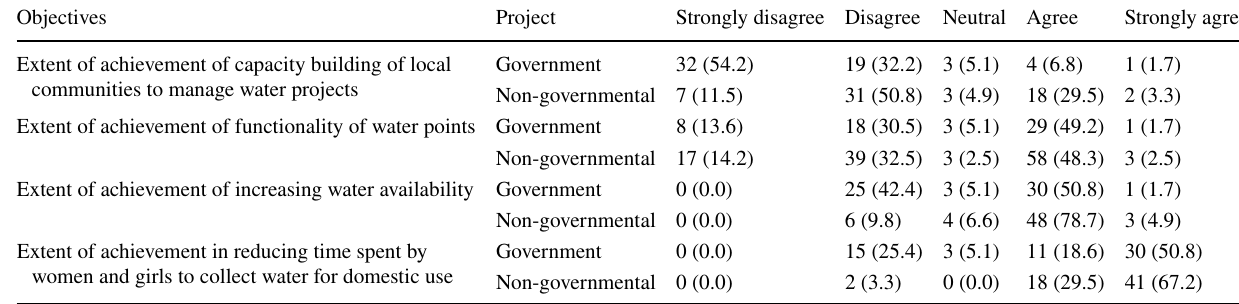
Table 4 Degree of achievement of water projects’